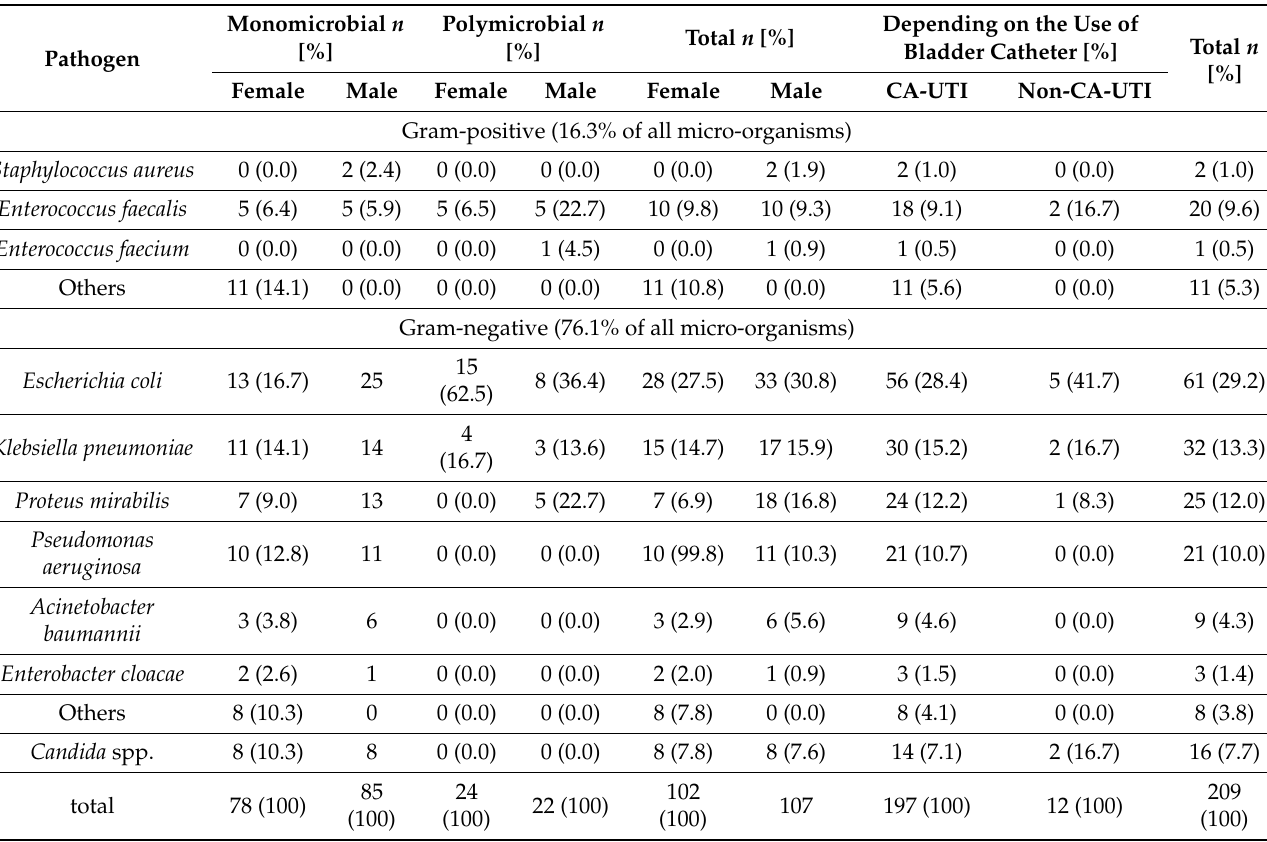
Table 1. The most frequently isolated etiological factors in microbiologically confirmed urinary tract infections—including 36 polymicrobial cases—in the Clinical Department of Orthopedic-Traumatic, Oncological, and Reconstructive Surgery in